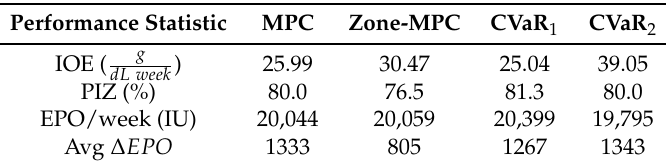
Table 7. Simulation results under Gaussian distribution.